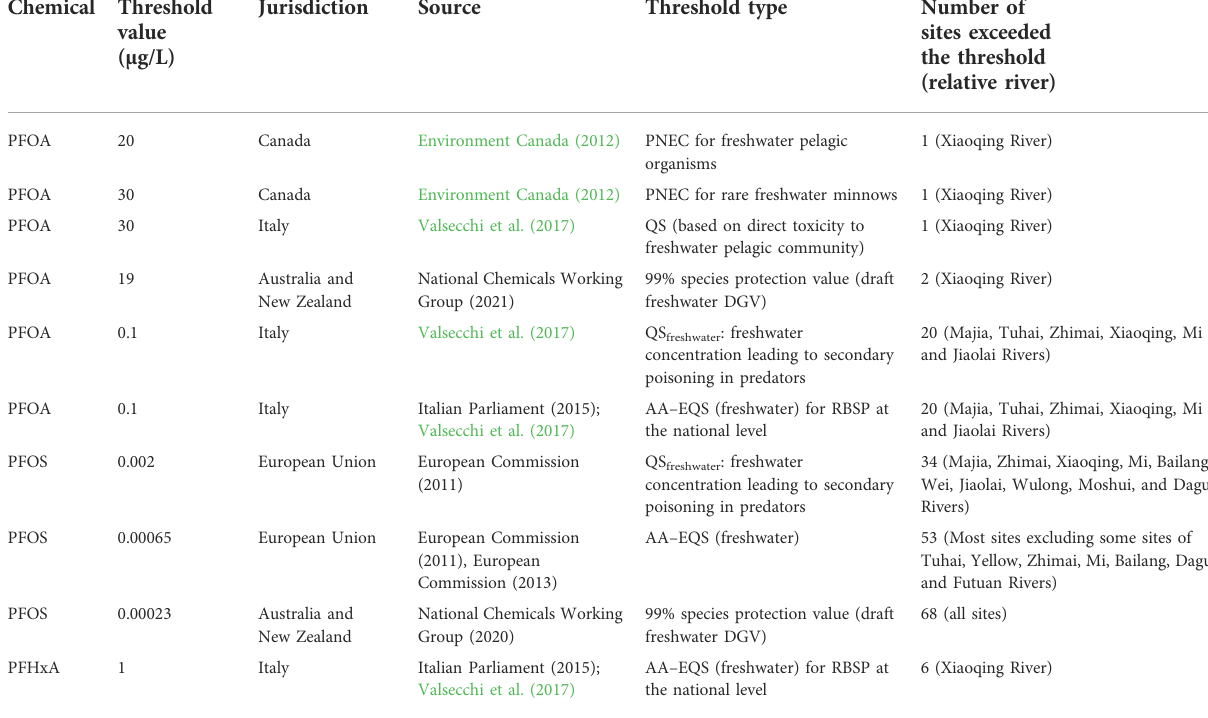
TABLE 1 The numbers of the studied sites exceeded the thresholds for ecological effects from around the world. Chemical Threshold